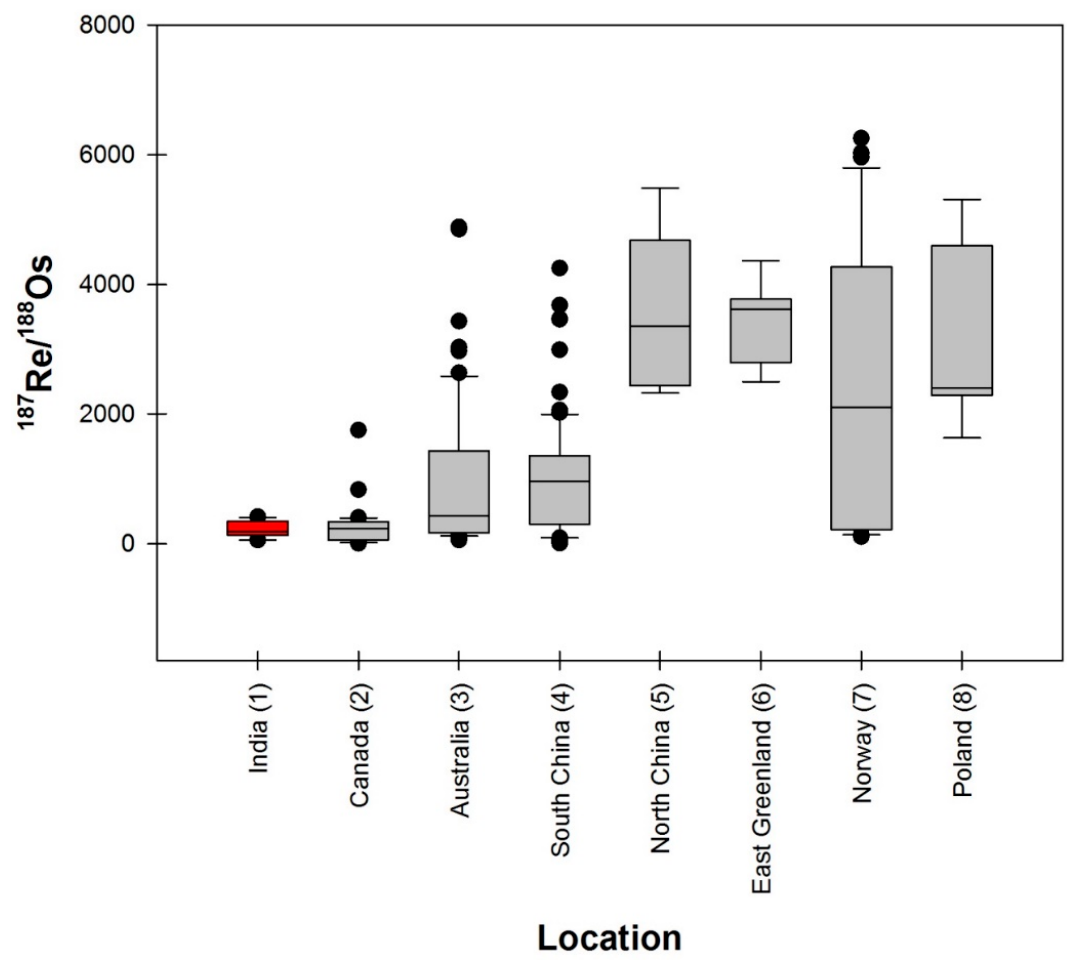
Figure 7. Global distribution of 187 Re/ 188 Os ratios for Late Permian sedimentary rocks from India (this study), Canada [71], Australia [33], South China [34], North China [70], East Greenland [8], Norway [8] and Poland [32]. The circles present the data point, whereas the box presents the data variance. Paleo-geographic position of these sites is shown in Figure 1; the sites in Figure 1 are referenced as per the number mentioned in the parentheses. The red box represents data from this study.